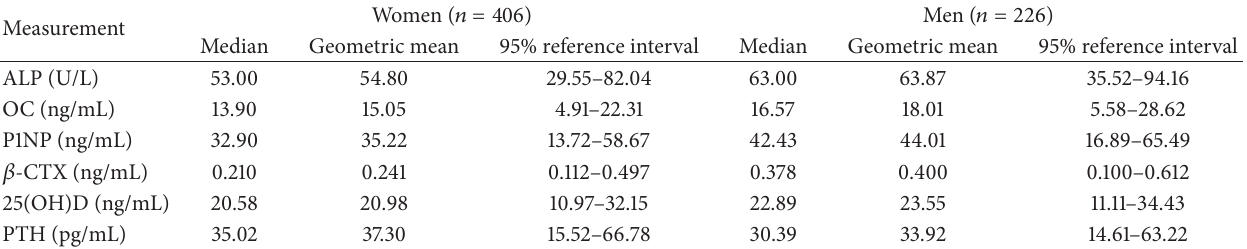
Table 2: Medians, geometric means, and 95% reference intervals for the bone turnover markers in 35–45-year-old subjects. Measurement